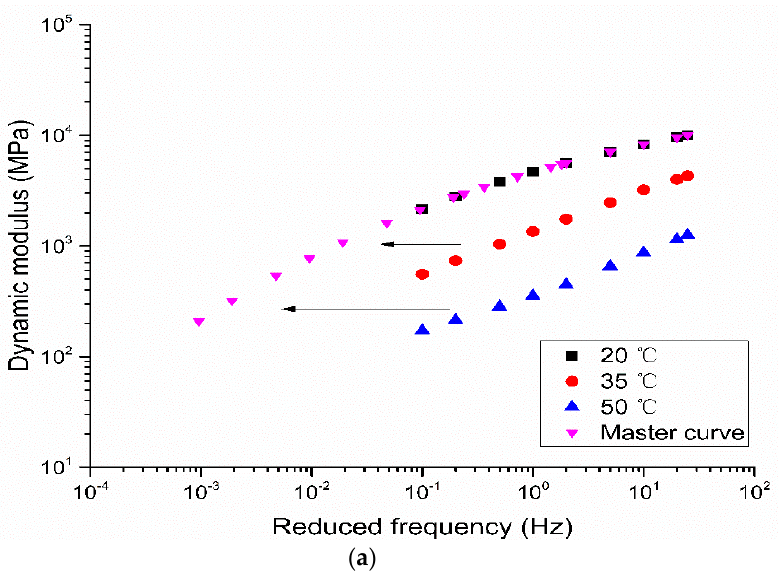
Figure 5. The correlation between the dynamic modulus and loading frequency (ACU: asphalt content in the upper half layer, ACL: asphalt content in the lower half layer): ( a ) 20 °C; ( b ) 35 °C; ( c ) 50 °C.